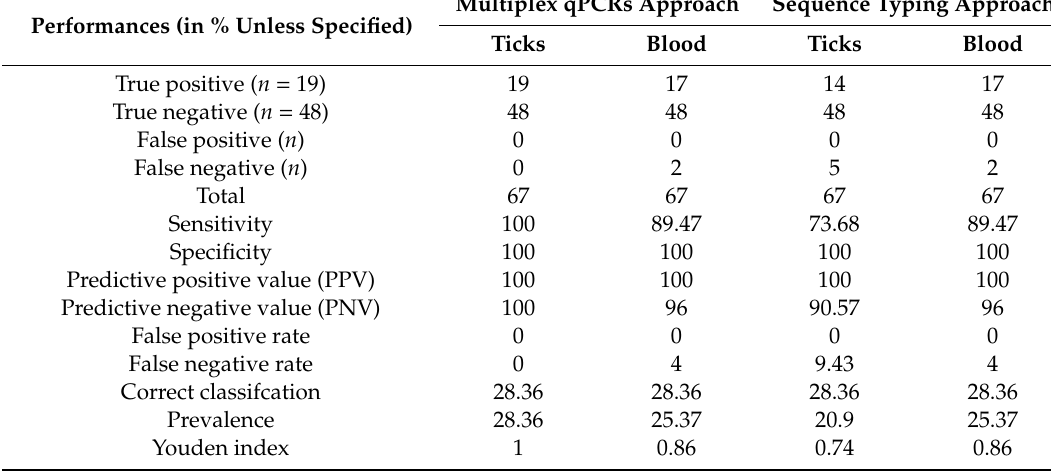
Table 6. Performance Characteristics of Molecular Assays in Identifying Filarial DNA from Canine Blood and